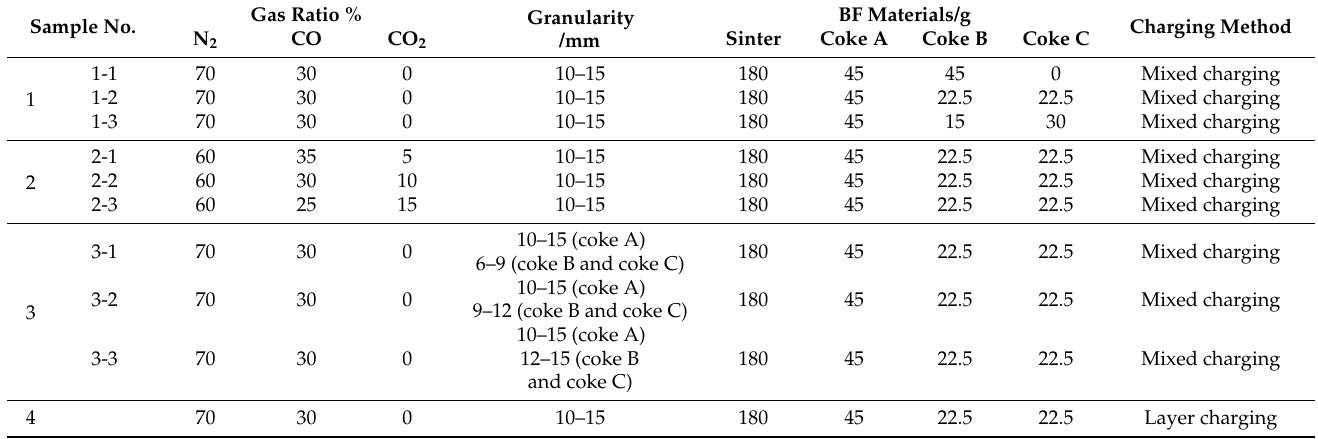
Table 3. Experimental schemes of sinter reduction